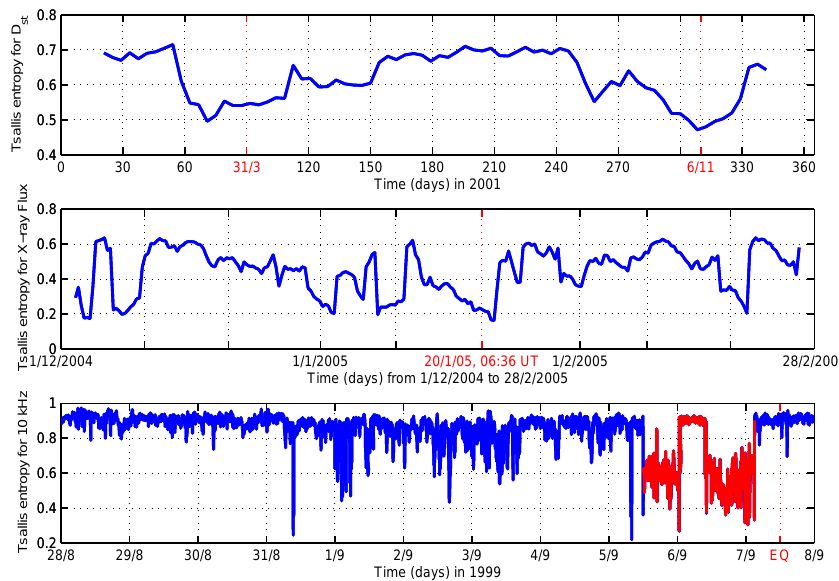
Fig. 4. Tsallis entropy variations of the D st index data for q = 1 . 84 (upper panel); X-ray flux data for q = 1.82 (middle panel);kHz EM recordings data for q = 1 . 84 (lower panel). The data correspond to the time series presented in Fig. 1. The red marks coincide with those of Fig.